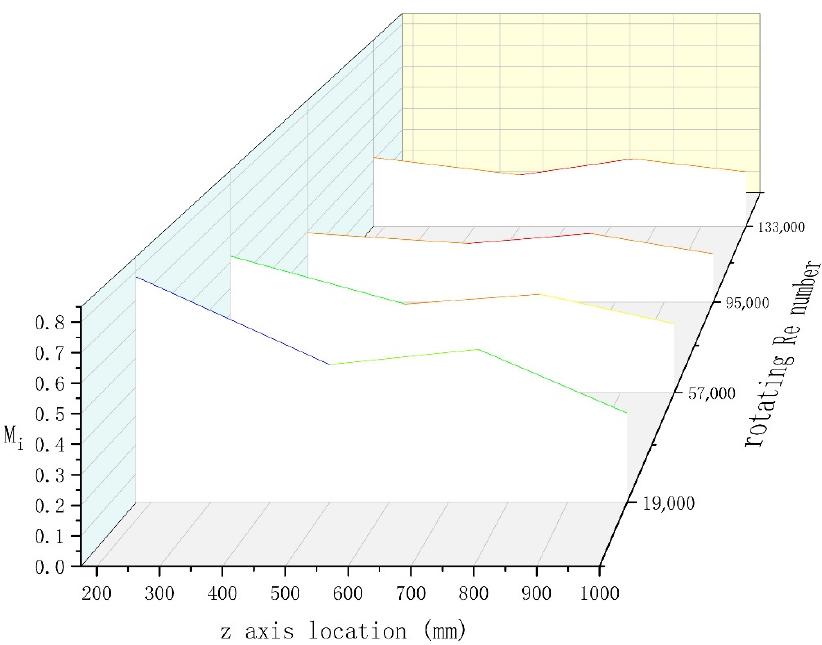
Figure 14. Gas phase homogeneity at different heights.